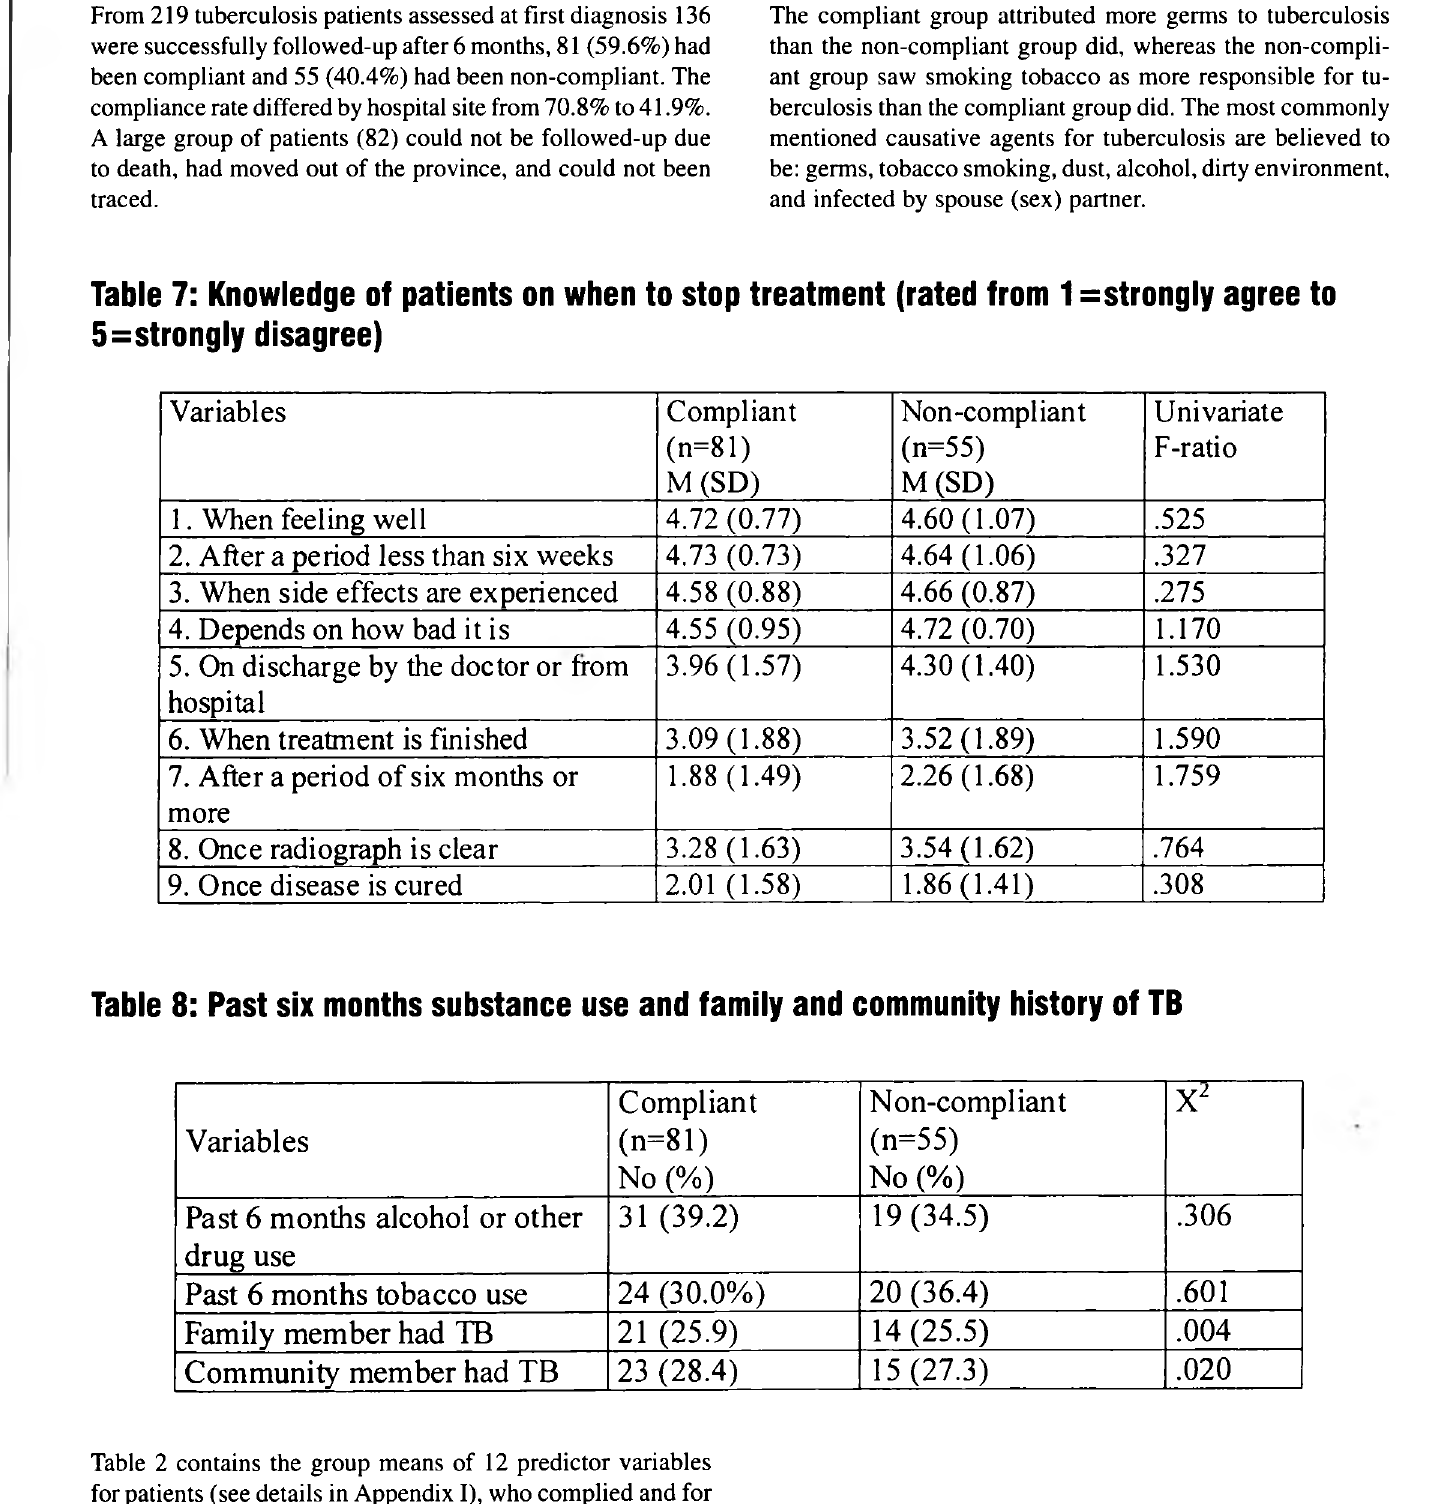
Table 8: Past six months substance use and family and community history of TB